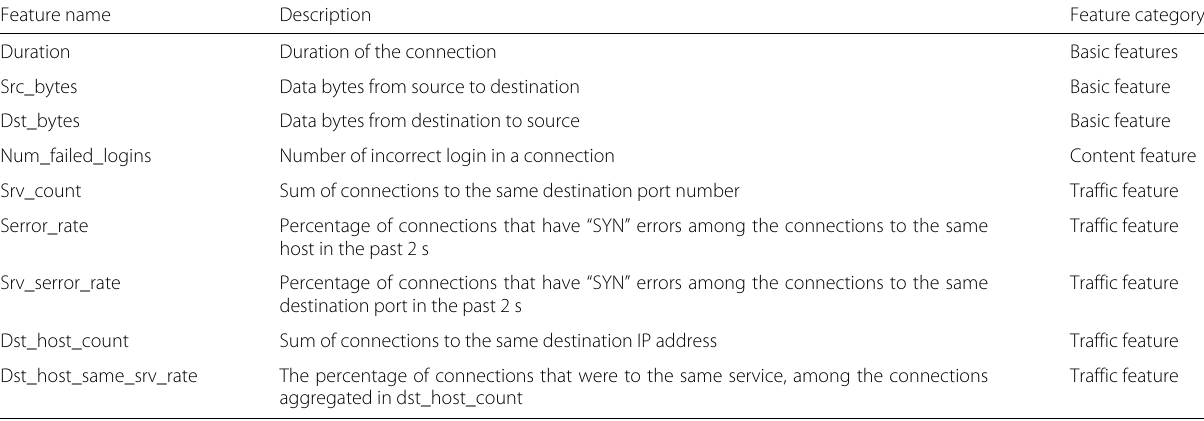
Table 4 Some selected features in